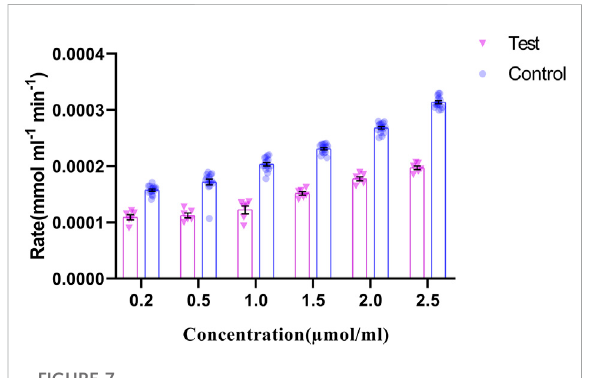
FIGURE 7 GRHPR Enzyme activity in the presence of different substrate (Glyoxylate) concentration (µmol/ml) between test (C.494G > A) (N = 6) and control samples (N = 10); and the rate of NADP formation demonstrated as mmol ml − 1 min − 1